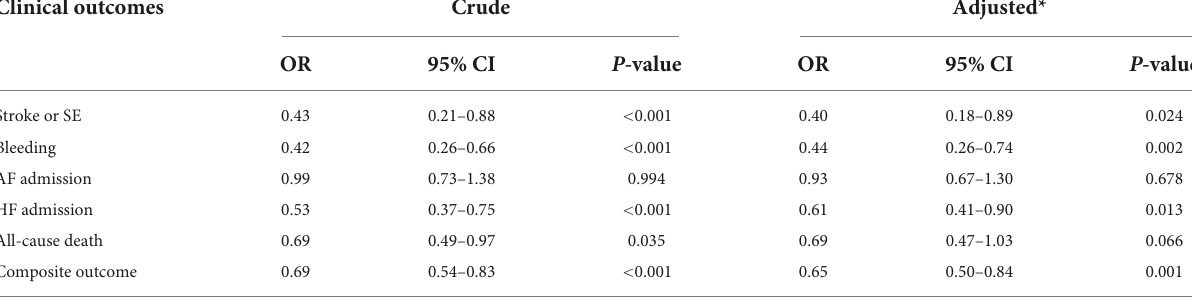
TABLE 3 Odds ratio of clinical outcomes comparing obese and non-obese